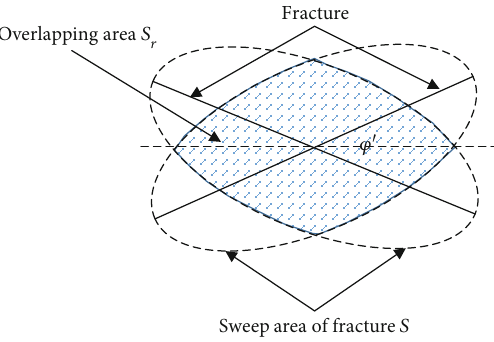
Figure 11: Sketch of a sweep area in